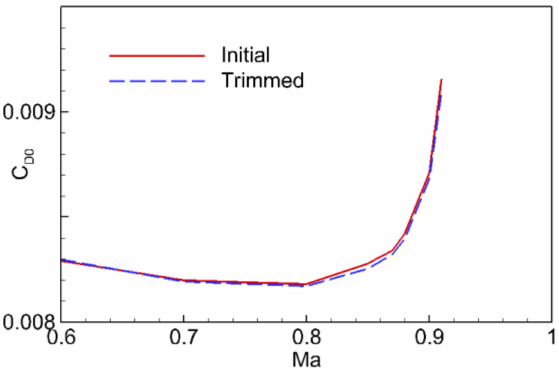
Figure 32. The drag divergence characteristics of the initial and the trimmed configuration.